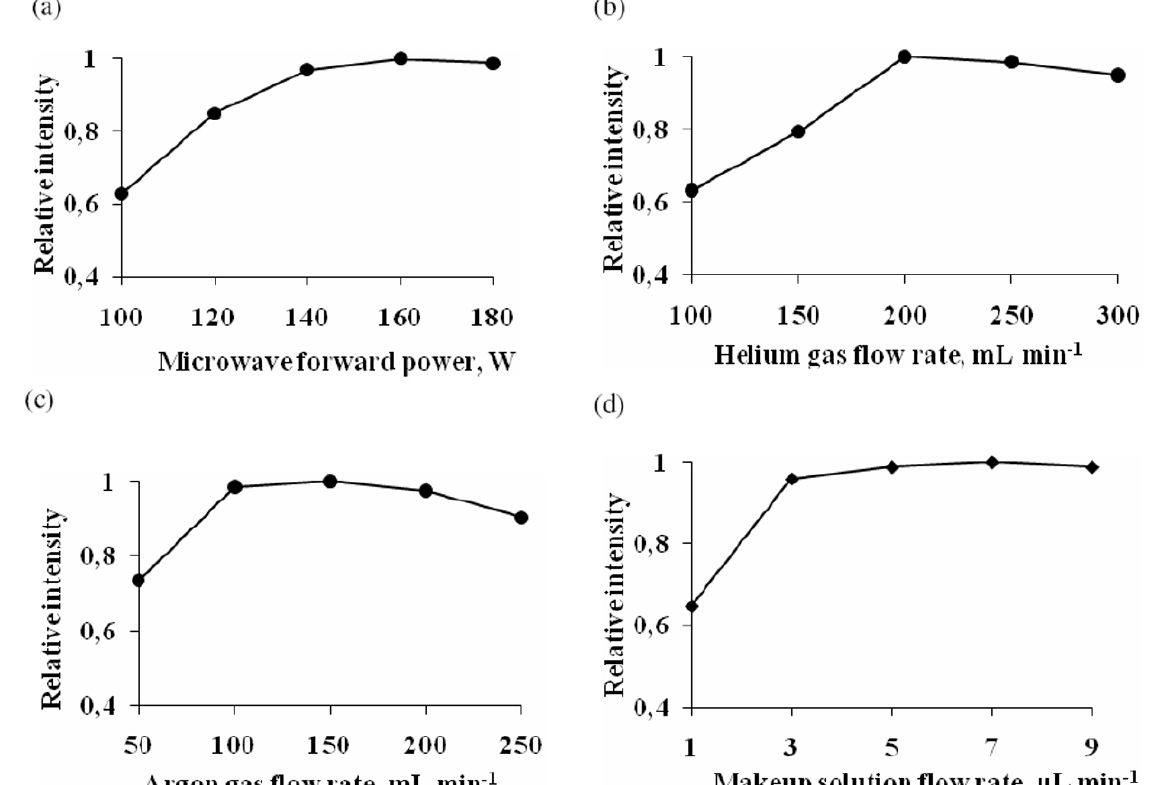
Figure 4. Effect of the variables on the copper normalized emission intensity for μCE-MIPOES system. Influence of (a) microwave forward power; (b) helium gas flow rate; (c) argon gas flow rate; (d) makeup solution flow rate on the emission intensity for continuous injection of 10 mg L -1 Cu (II) through make-up channel without application of voltage.